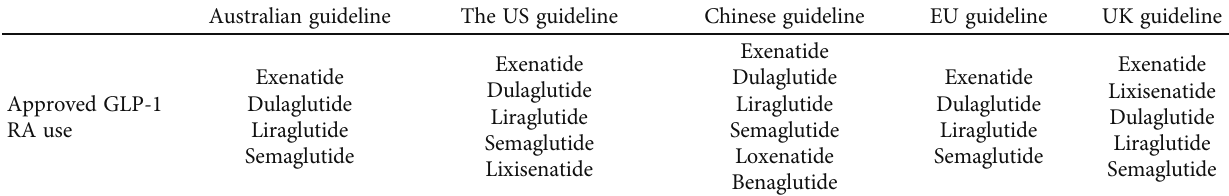
Table 1: Summary of GLP-1 RA guidelines in di ff erent